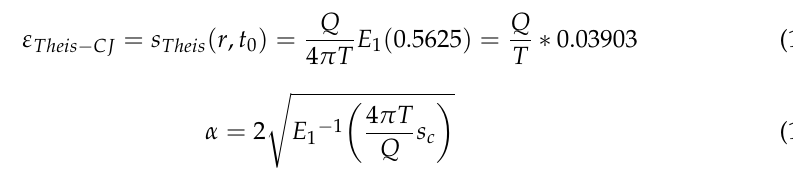
Figure 4. ( A )—Comparison of α values from Theis and CJ models; ( B )—Representation of α estimation error of CJ model compared to α estimation from Theis model.